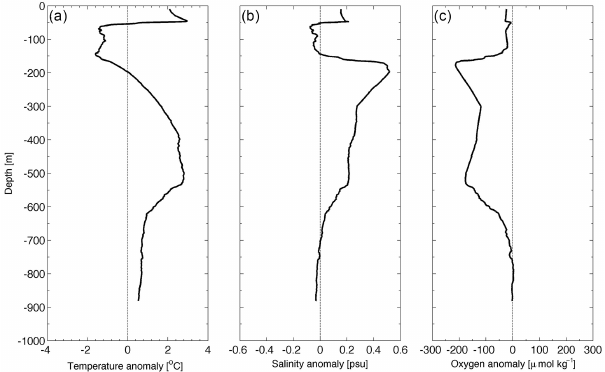
Figure 3. Vertical anomalies of (a) temperature ( ◦ C), (b) salinity, (c) dissolved oxygen (µmolkg − 1 ) in station 094-A compared with WOA 2013 climatology (range of years for